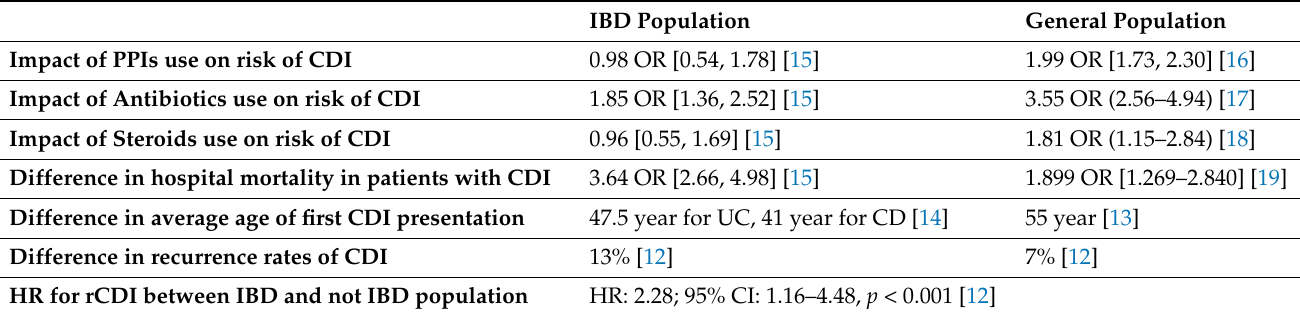
Table 1. Differences in risk factors, age of first presentation, and recurrence rates for CDI between IBD and general population. PPIs—proton-pump inhibitors, OR—odds ratio, HR—hazard ratio. IBD Population General Population Impact of PPIs use on risk of